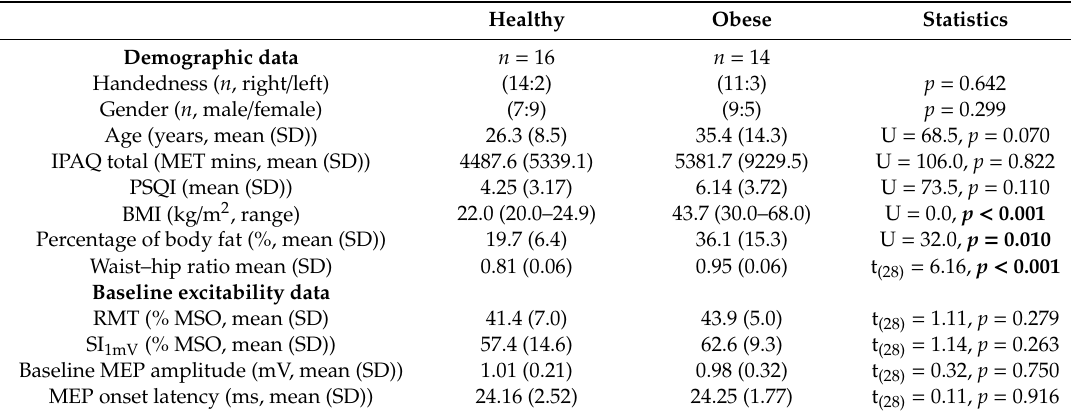
Table 1. Participant demographics, characteristics, and baseline neurophysiological data.